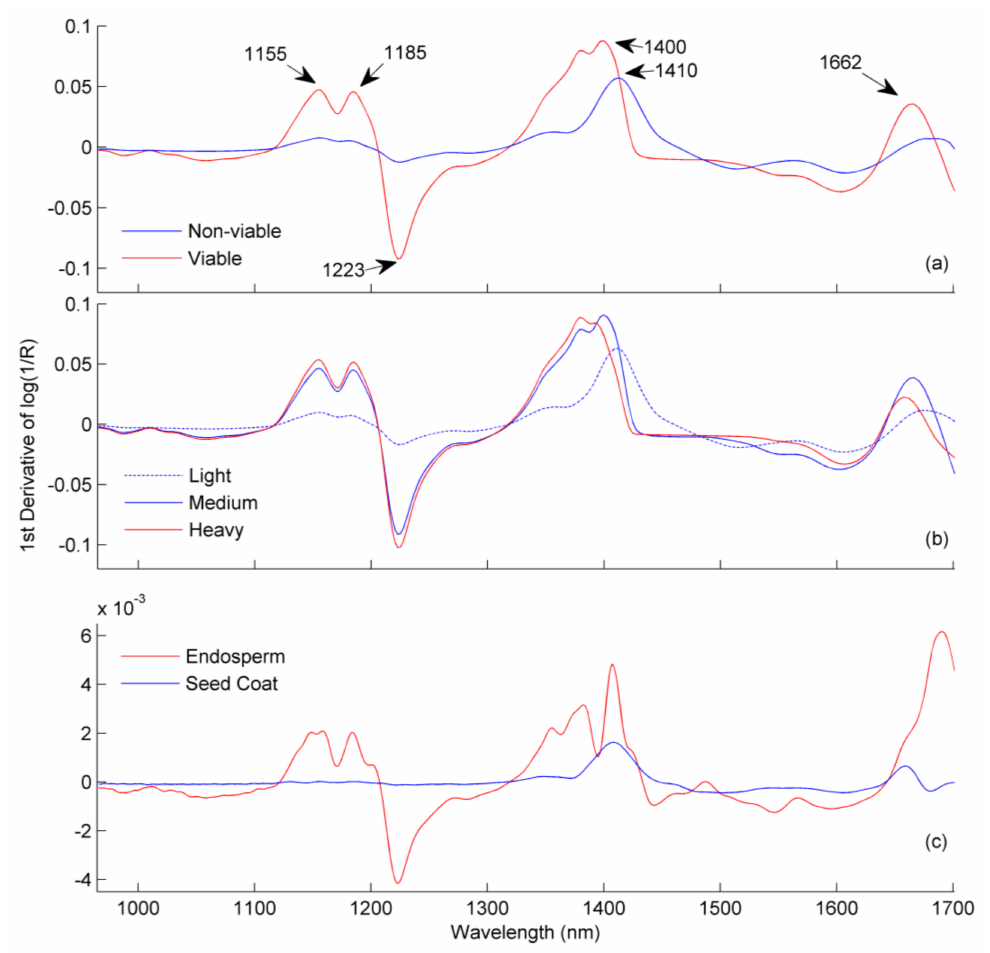
Figure 2. The average pre-processed absorbance from 965 to 1701 nm for ( a ) viable vs. non-viable seeds, ( b ) light, medium and heavy seeds and ( c ) endosperm vs. seed coat of castor seeds. Near-infrared (NIR) spectra in ( a , b ) are from single-seed measurements whereas NIR spectra in ( c ) are from glass